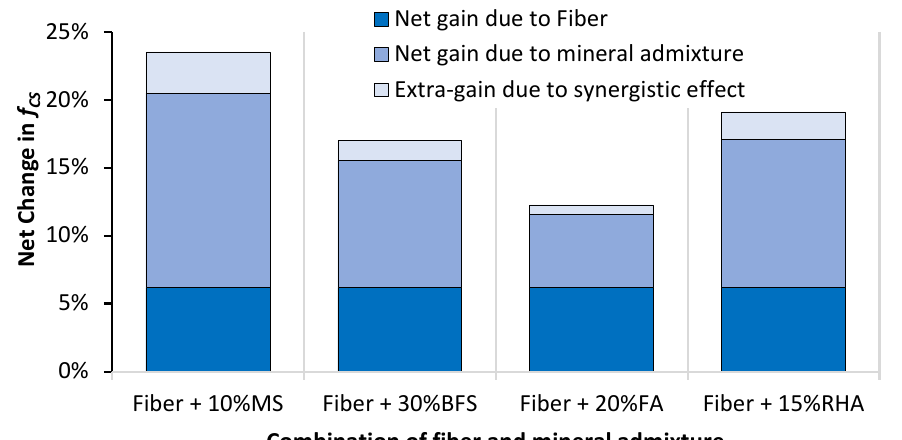
Figure 8. Effect of combined incorporation of mineral admixtures and glass fibers on the net change in f CS of RAC.